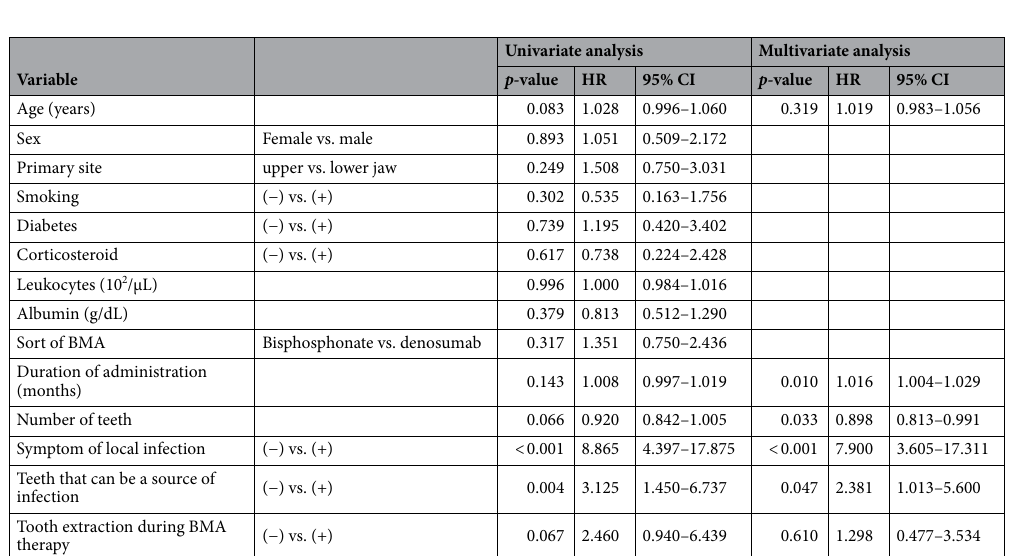
Figure 1. Cumulative occurrence rate of MRONJ. The incidence of MRONJ increases over time, and the 1-, 2-, 3-, 4-, and 5-year cumulative occurrence rates are 8.1%, 14.7%, 18.2%, 18.2%, and 23.3%, respectively.